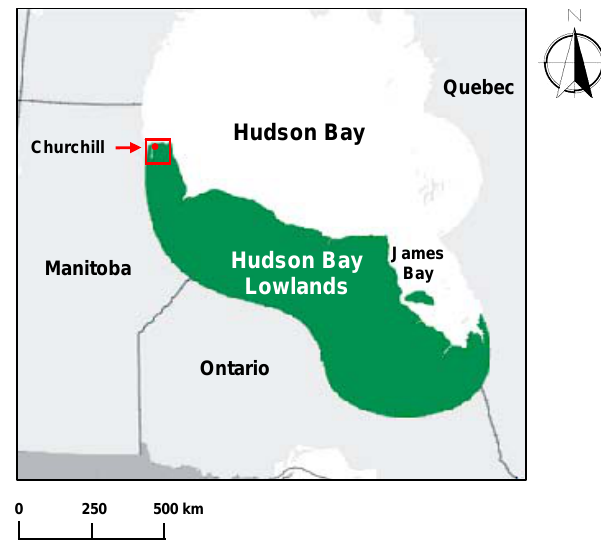
Fig. 1. The location of the study area (red square) and the town Fig. 1 – The location of the study area (red square) and the town of Churchill (red point) in of Churchill (red point) in the Hudson Bay Lowlands, north-eastern the Hudson Bay Lowlands, north-eastern Manitoba, Canada. The Hudson Bay Lowlands is the Manitoba, Canada. The Hudson Bay Lowlands is the second largest second largest contiguous peatland worldwide (after the West Siberian Lowlands in Russia), contiguous peatland worldwide (after the West Siberian Lowlands in Russia), where wetlands embrace 50–75% of the area (Ricketts where wetlands embrace 50-75% of the area (Ricketts et al. 1999). The green area in this map et al., 1999). The green area in this map represents the contiguous represents the contiguous peatland that covers approximately 324,000 km 2 of land (modified from peatland that covers approximately 324000 km 2 of land (modified the source map of University of Maine Canadian-American Center Cartography, 2005). from the source map of University of Maine Canadian-American Center Cartography,